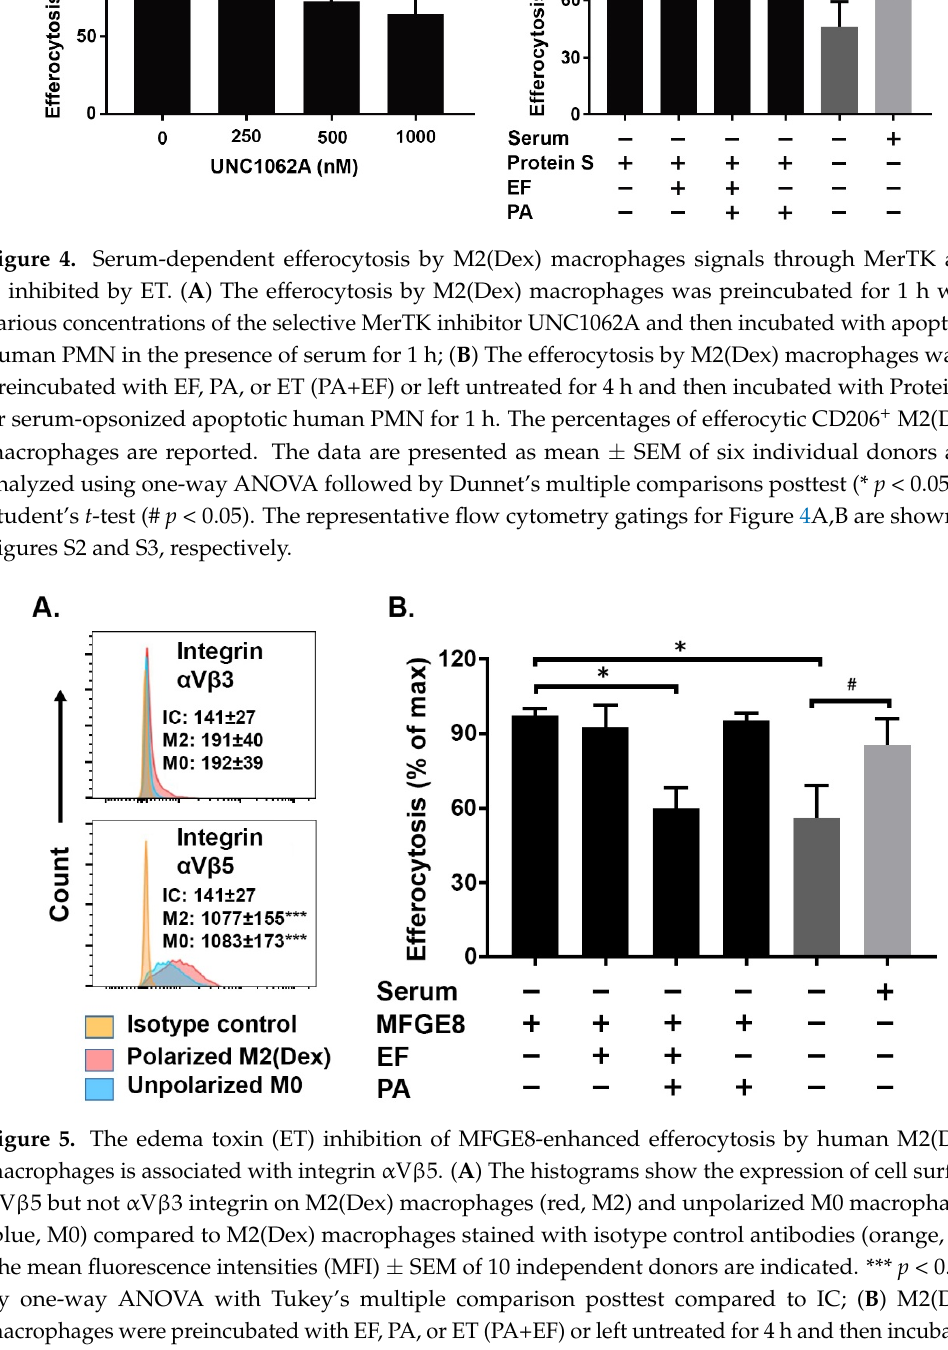
To determine if ET inhibits Rac1 activation in M2(Dex) macrophages downstream of MerTK, M2(Dex) macrophages were preincubated in the presence or absence of ET for 4 h and then cocultured with Protein S-opsonized apoptotic PMN under serum-free conditions for 15 min. Lysates from each condition were subjected to the pull-down of the active form of Rac. The total and pulled-down Rac1-GTP were quantified by a Western blot. The amount of active Rac1 pulled down from lysates of M2(Dex) macrophages that had been exposed to ET was substantially reduced (Figure 6), indicating that ET inhibits Rac1 activation downstream of the MerTK efferocytic receptor signaling. Similar results were observed in M2(Dex) macrophages stimulated with MFGE8-opsonized apoptotic PMN (Figure S4).